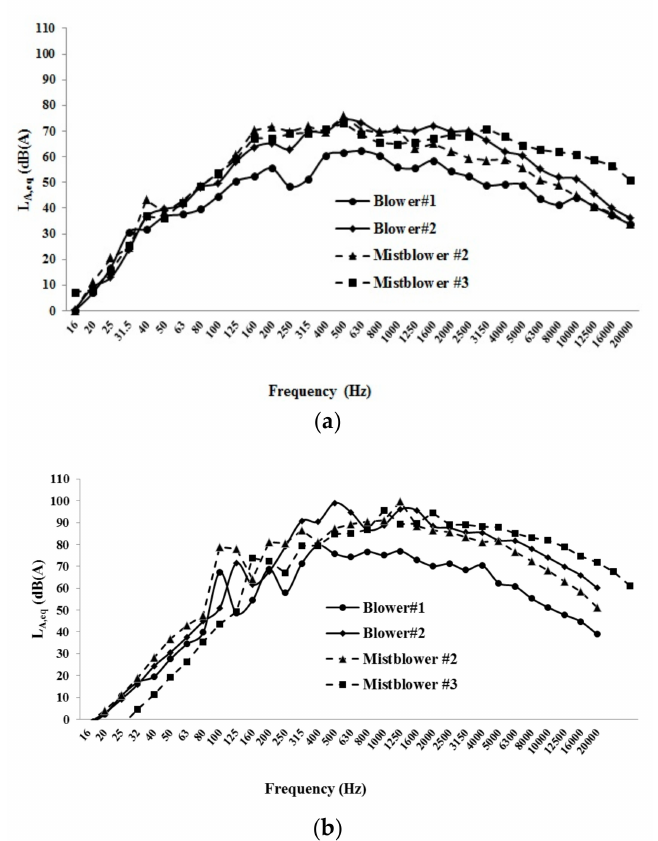
Figure 12. Sound pressure levels of blower #1, blower #2, mist blower #2, and mist blower #3 at LES (low engine speed) ( a ) and at HES (high engine speed) ( b